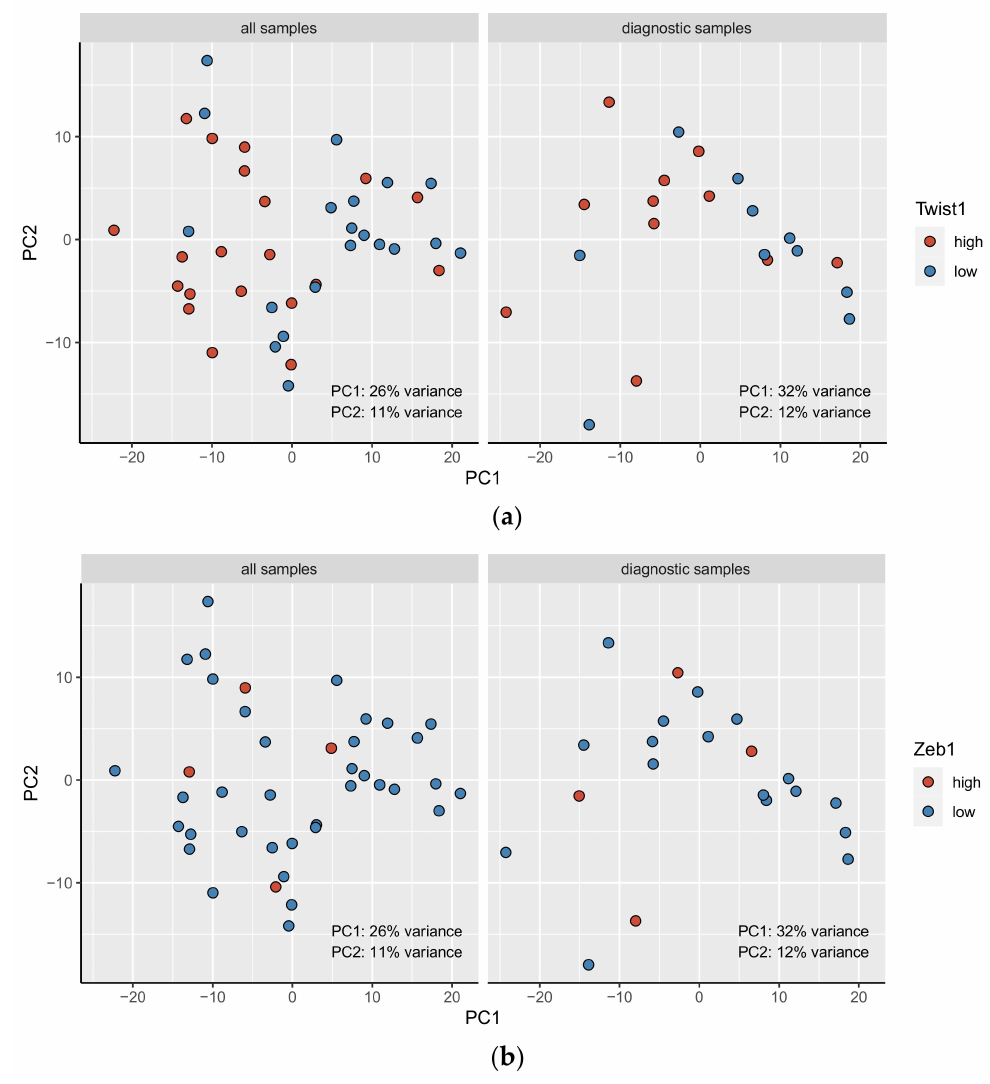
Figure 3. First two principal components of the PCA, with Twist1 ( a ) and Zeb1 ( b ) expression cate- gories for all samples ( n = 40) and diagnostic samples only ( n = 21). Blue indicates low Twist1/Zeb1 expression, and red indicates high Twist1/Zeb1